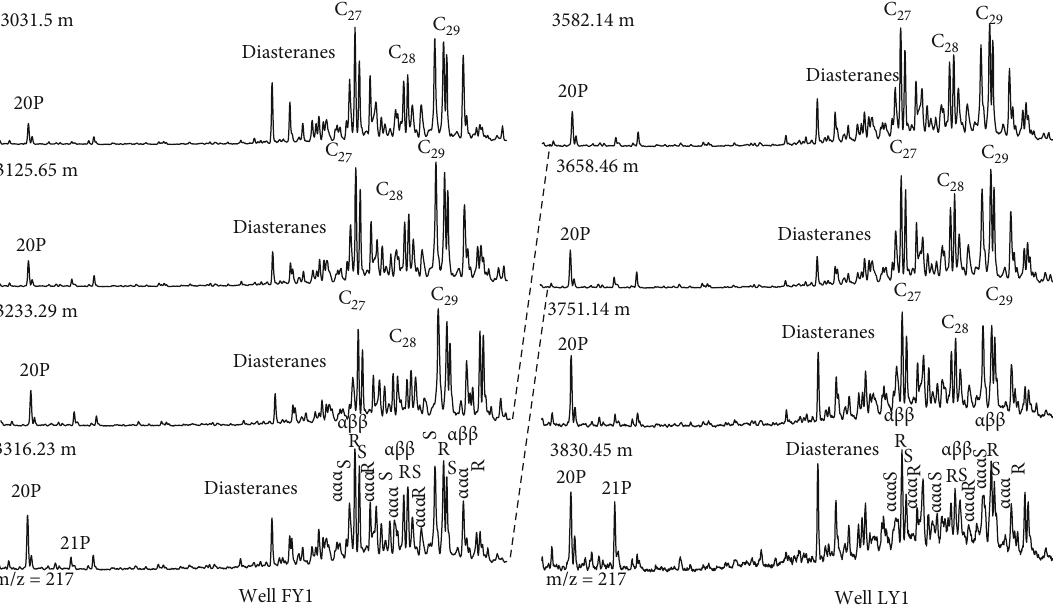
D/ ð C D + C H Þ . (c) TT/ ð TT + PT Þ . 30 30 30